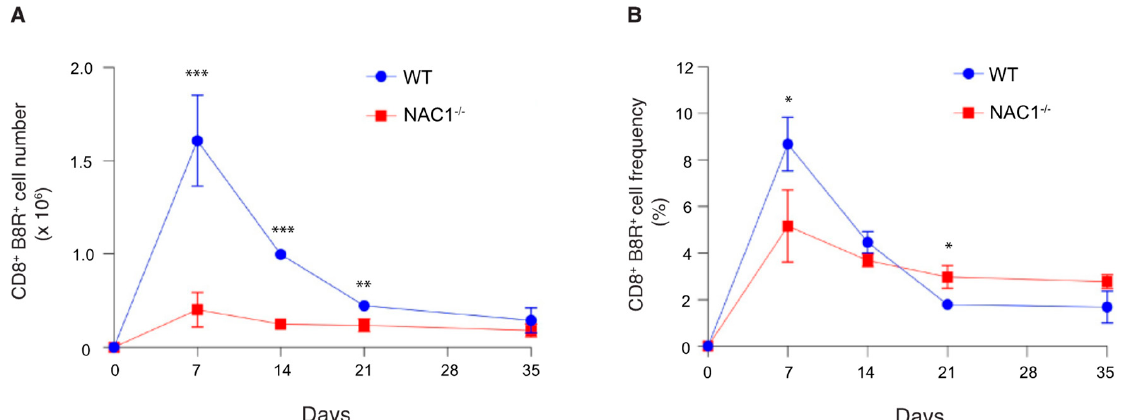
Figure 4. Sustained VACV-specific CD8 + T cell survival in NAC1 − / − mice. The VACV-specific CD8 + T cell number and cell frequency changed within 35 days post-infection. ( A ) Mice were challenged with VACV at 2 × 10 6 PFU/mouse. The spleen and lymph nodes (superficial cervical, axillary, brachial, and inguinal nodes) were dissected and smashed. The total live cell number for each mouse was calculated with trypan blue staining using a Bio-Rad cell counter. T cells were stained with CD8 Ab and B8R tetramer and analyzed by flow cytometry. Total Ag-specific CD8 + T cells were calculated for each mouse ( n = 5). The p -values are 0.00038 (day7), 8.2 × 10 − 5 (day 14), and 0.0066 (day 21). ( B ) The Ag-specific CD8 + T cell frequency was monitored for 35 days. P-values are 0.011 (day 7), and 0.016 (day 21). (*, p < 0.05; **, p < 0.01; ***, p < 0.001).